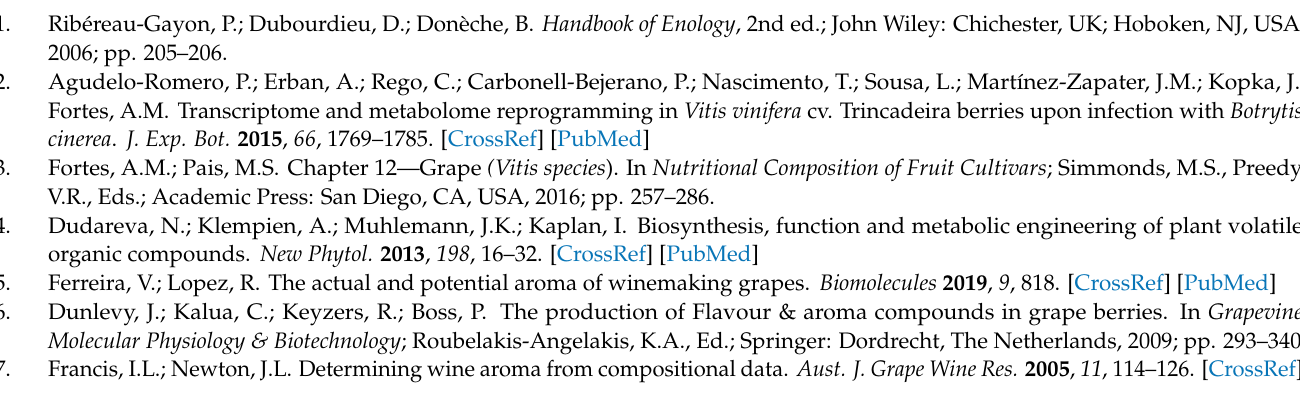
Table S1: Free and glycosidic bound volatile organic compounds expressed as percentage of total volatile organic compounds content in both control and Botrytis cinerea infected Trincadeira